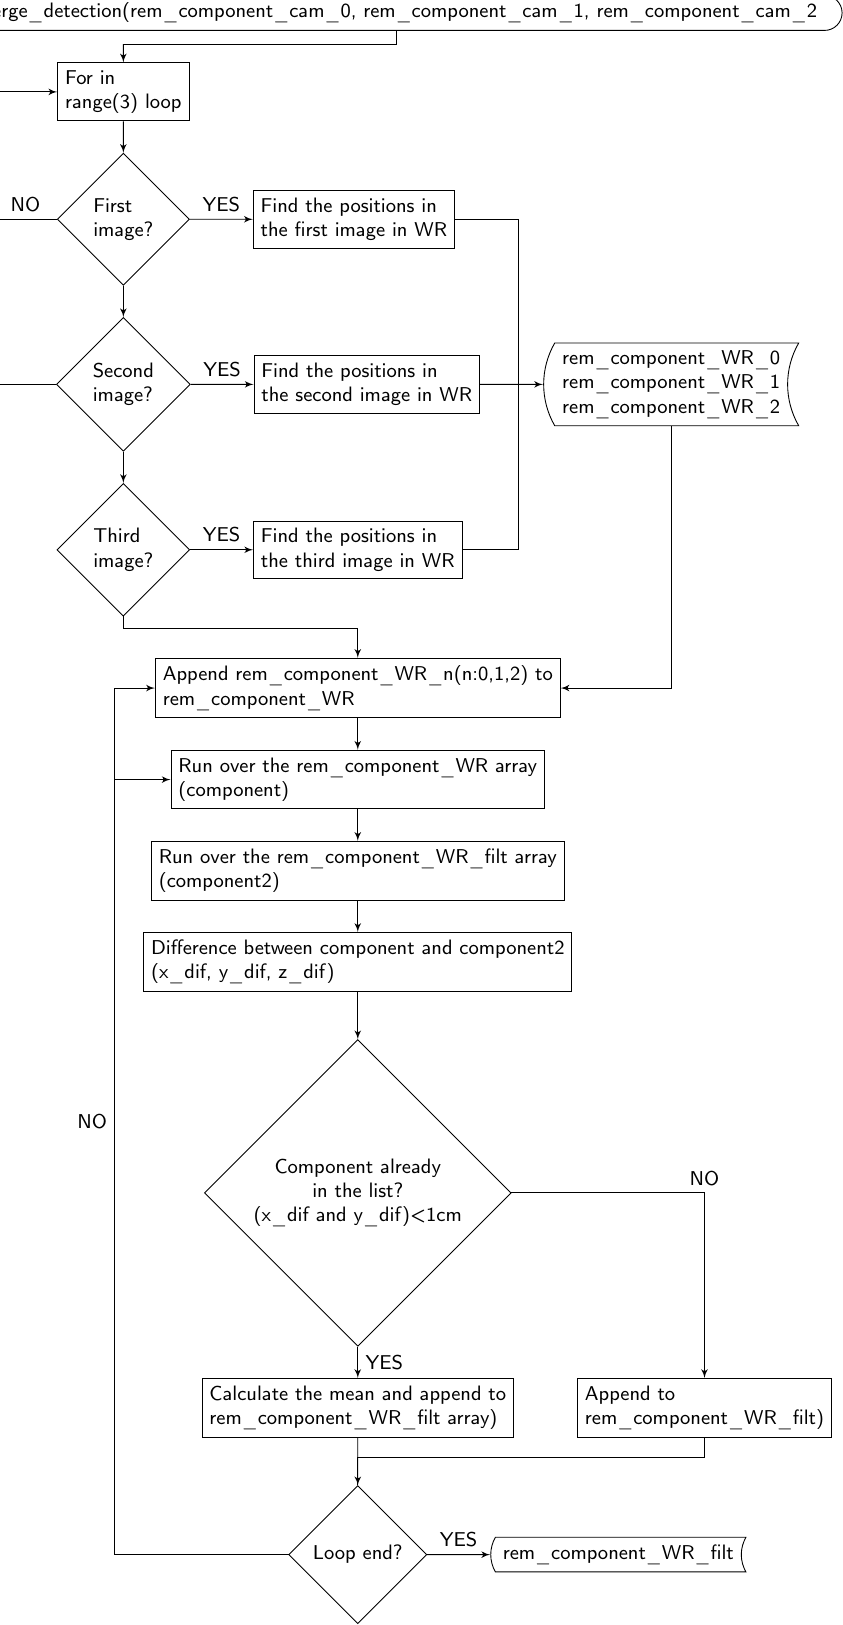
Figure 8. Function merge_detection flow chart